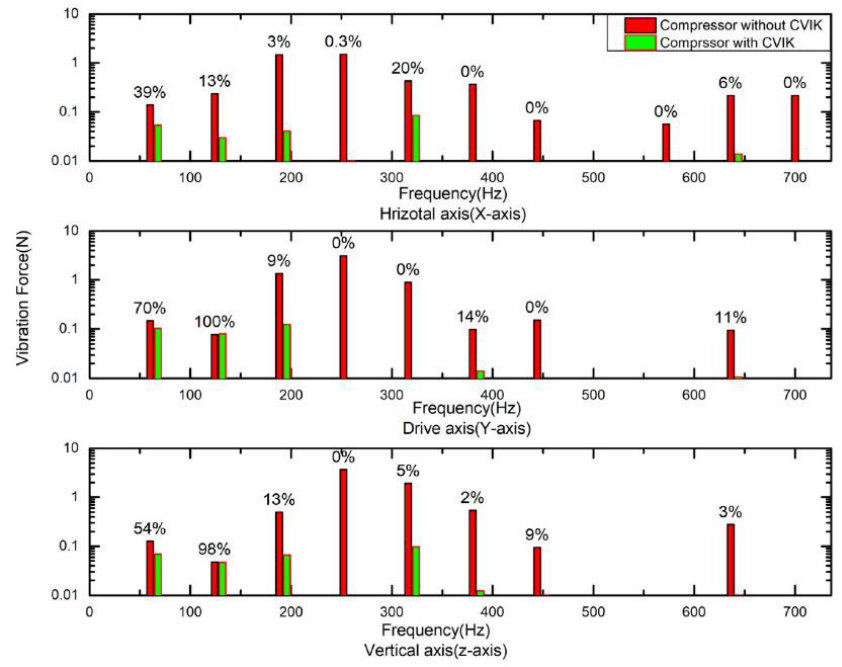
Figure 6. Comparison of PTC vibration level with and without a compressor isolation system.